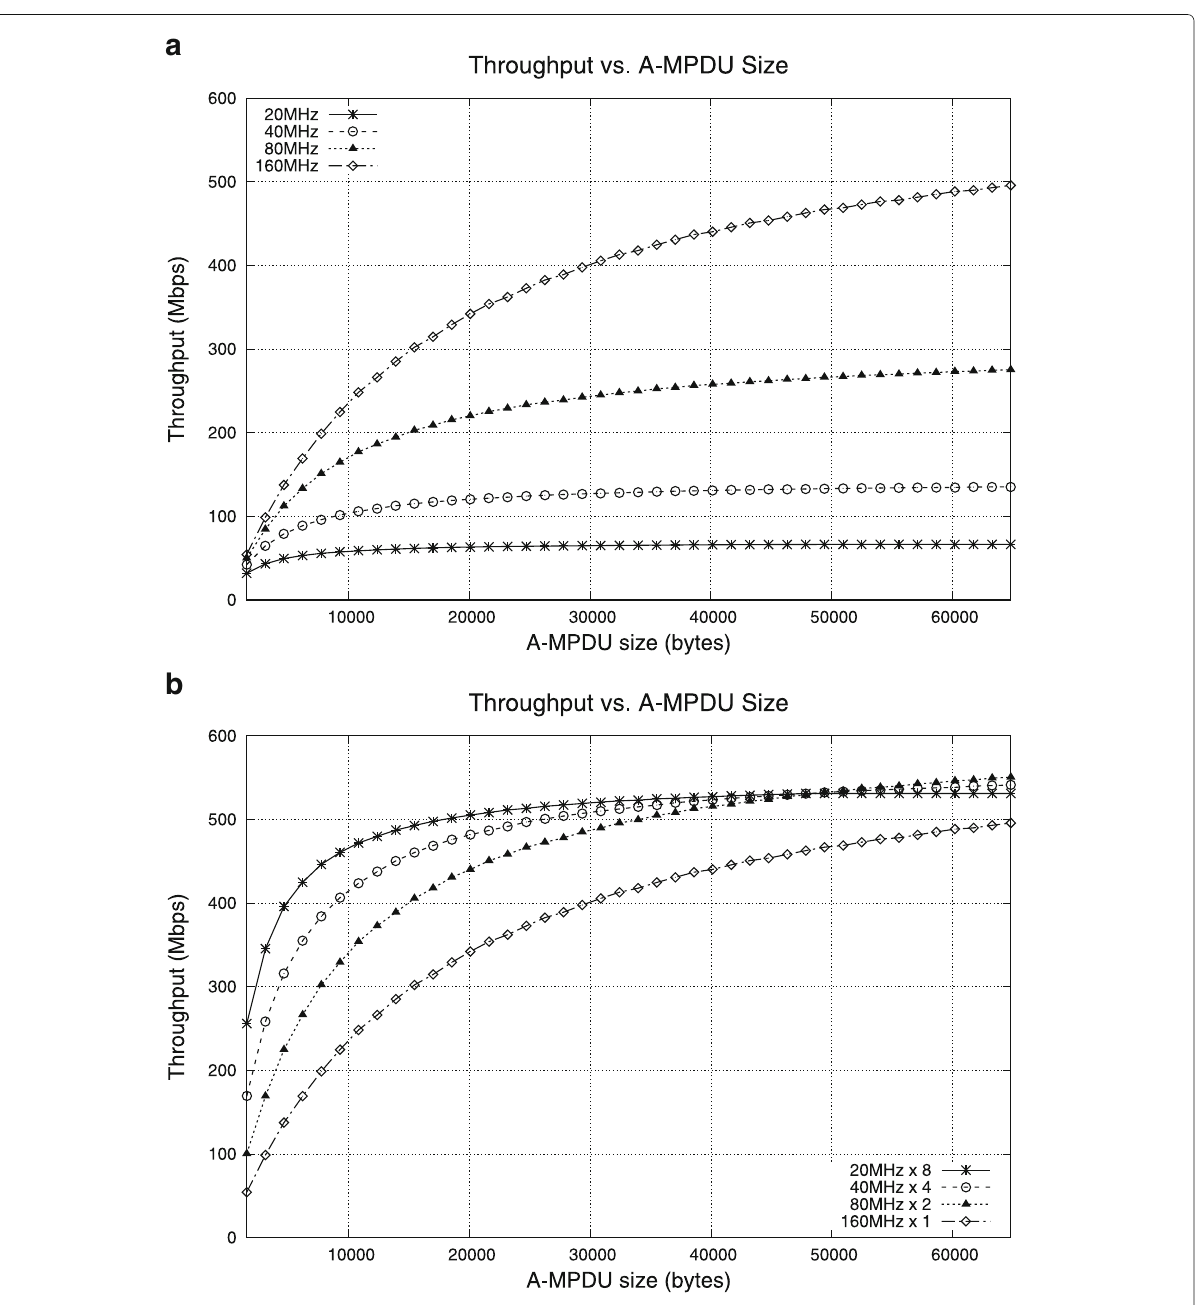
Fig. 2 Average throughput varying packet size. a Single channel with different widths. b Fixed aggregate width (160